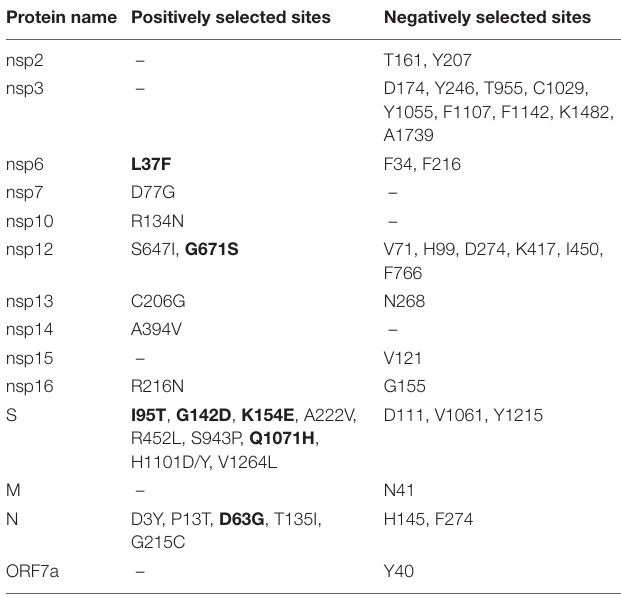
TABLE 1 | Positively and negatively selected sites in coding regions of